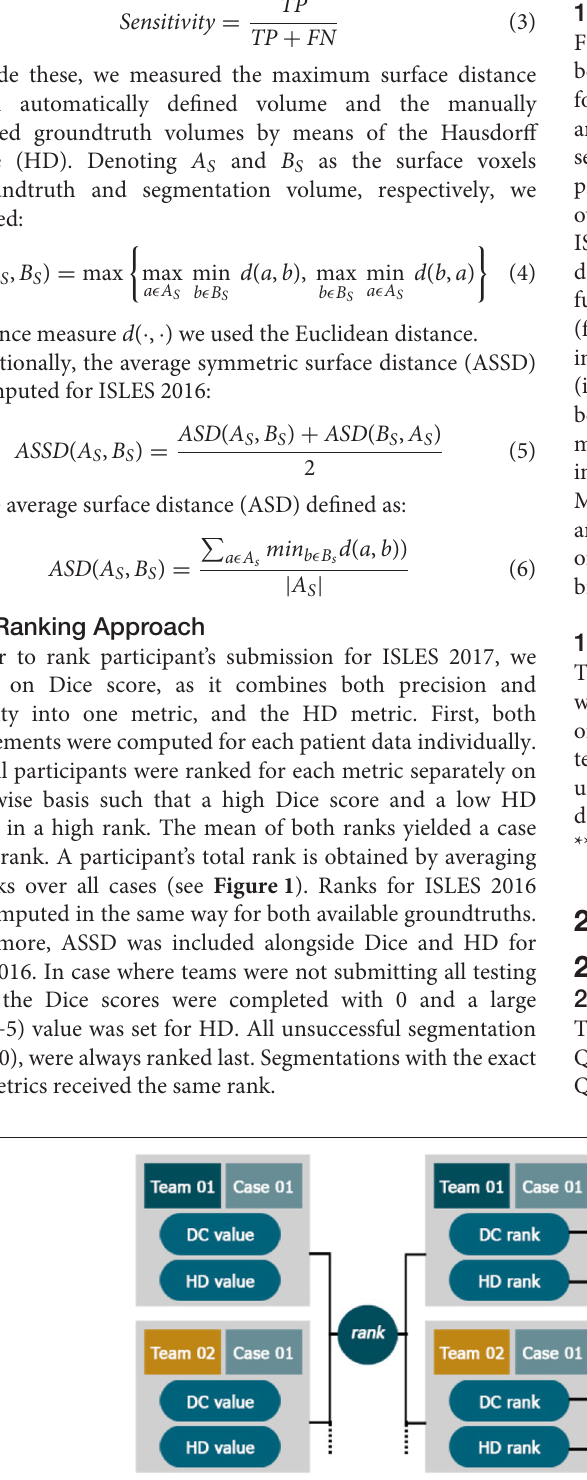
Frontiers in Neurology |